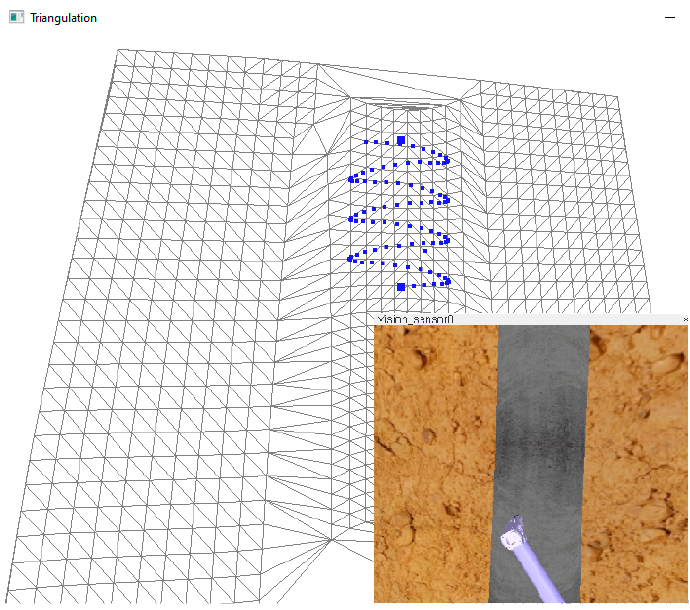
Figure 7. Interface for controlling the formation of motion trajectories of the MM working tool.